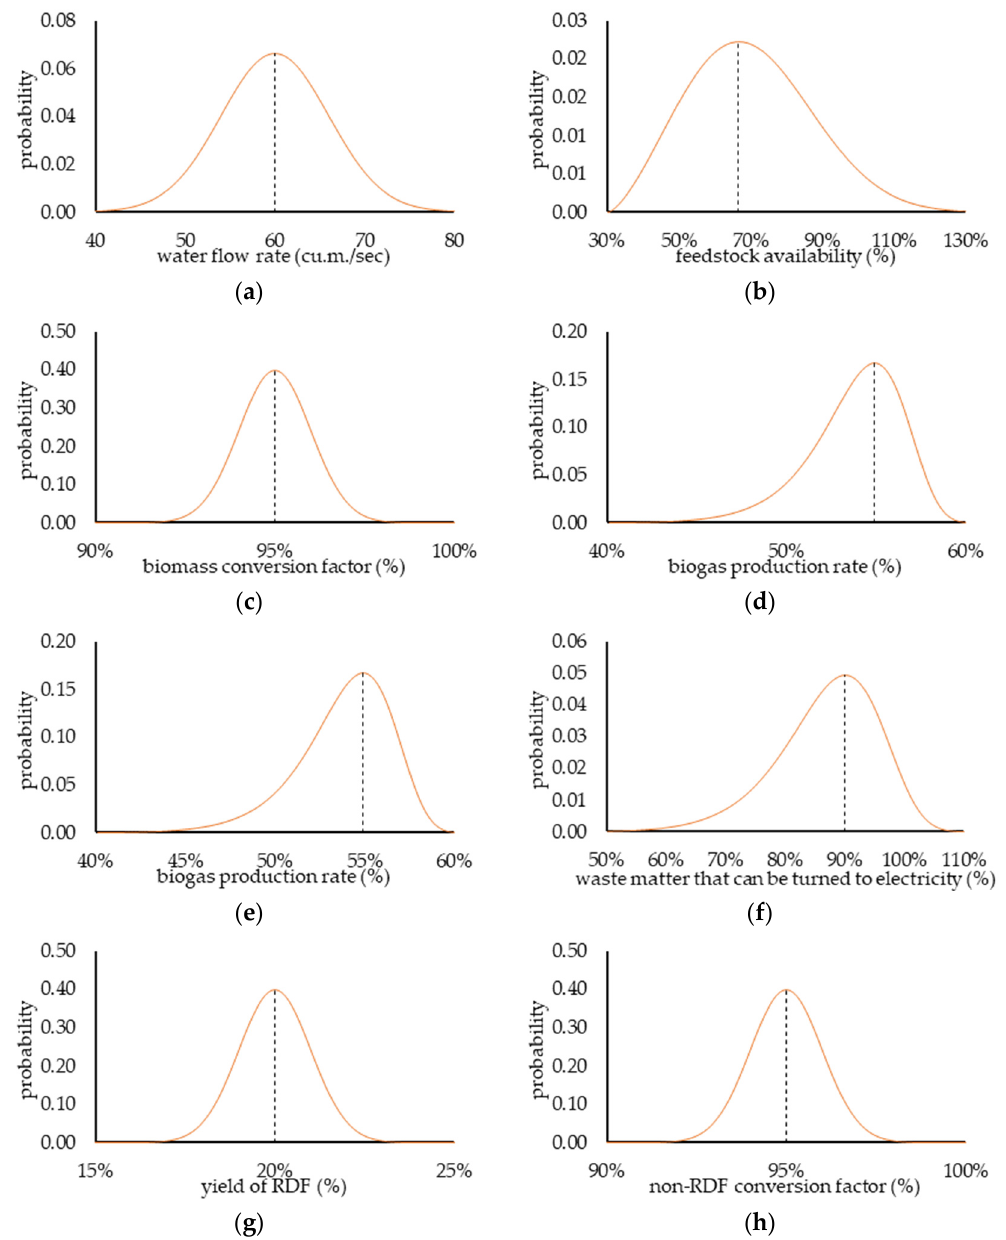
Figure 21. Probability distribution function of ( a ) water flow rate of small hydro; ( b ) feedstock availability; ( c ) biomass conversion factor; ( d ) biogas production; ( e ) biogas conversion factor; ( f ) waste matter that can be turned to electricity; ( g ) yield of RDF; and ( h ) non-RDF conversion factor.